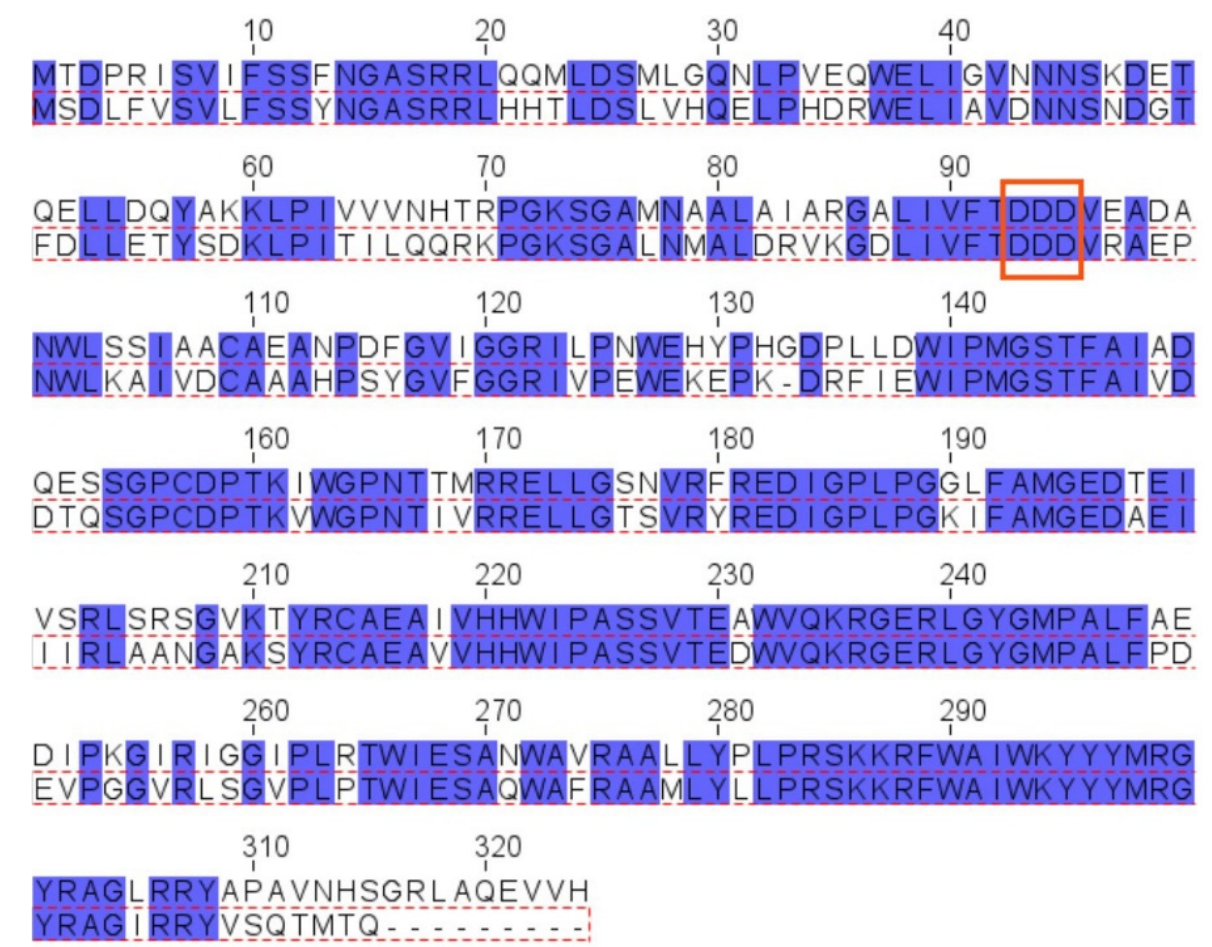
Figure 3. Alignment of amino acid sequences of PssG and PssI proteins. Alignment was performed with Clustal Omega and visualized in Jalview. Top aa sequence: PssG (QBN20832.1), bottom aa sequence: PssI (QBN20830.1) (red dotted frame). Blue boxes mark identical amino acids. Red frame marks the position of the DXD motif.